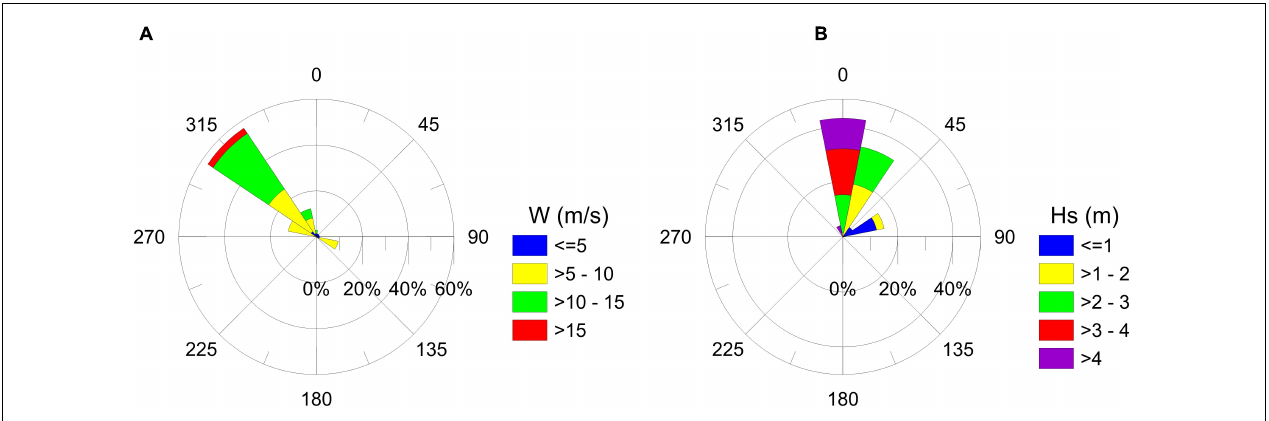
FIGURE 2 | (A) Wind velocity and (B) significant wave height roses associated to the Winter Storm Number 12 (November 12–15, 2019).